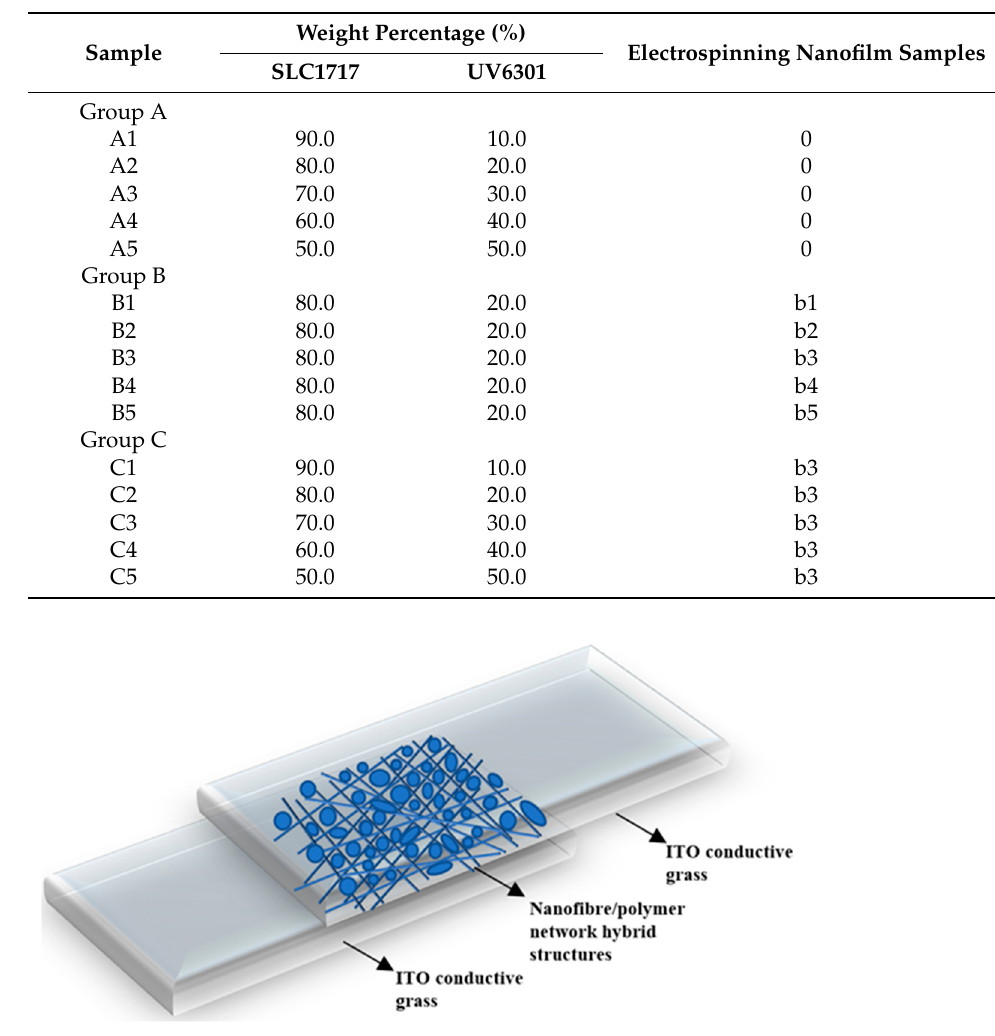
Table 2. Sample compositions.